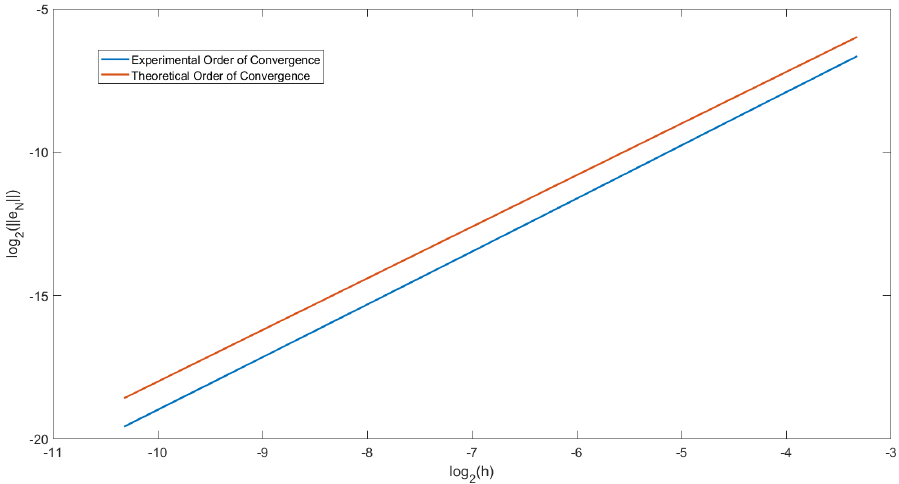
Figure 1. Graph showing the experimental order of convergence (EOC) at T = 2 in Example 1 with α =